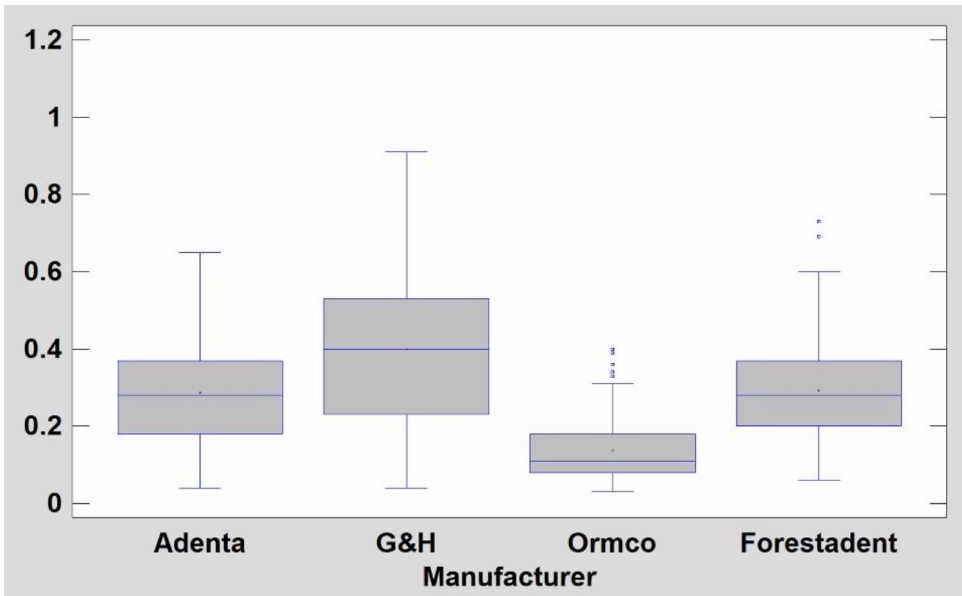
Figure 6. NiTi archwire comparison (mean side 1 and side 2 texture index, TI; higher TI means better result). Adenta wires are significantly ( p < 0.05) smoother than the last 3 manufacturers’ products. G&H are significantly better ( p < 0.05) than Ormco and Forestadent wires. Moreover, Forestadent wire is worse than all other products ( p < 0.05), y axis indicates values of texture